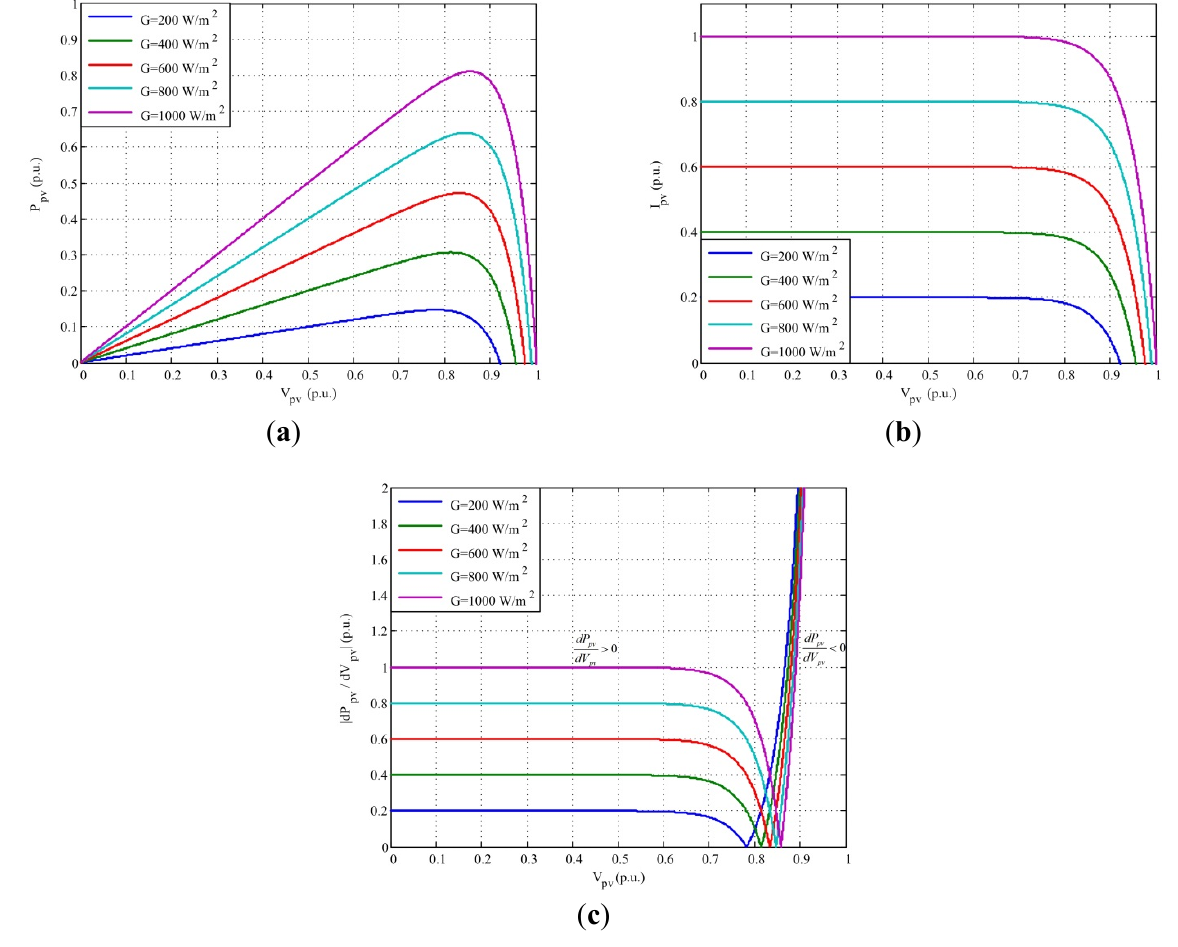
Figure 3. I ‒ V and P ‒ V curve for the utilized PV panel ( a ) I ‒ V curve; ( b ) P ‒ V curve; ( c ) | dP pv / dV pv |